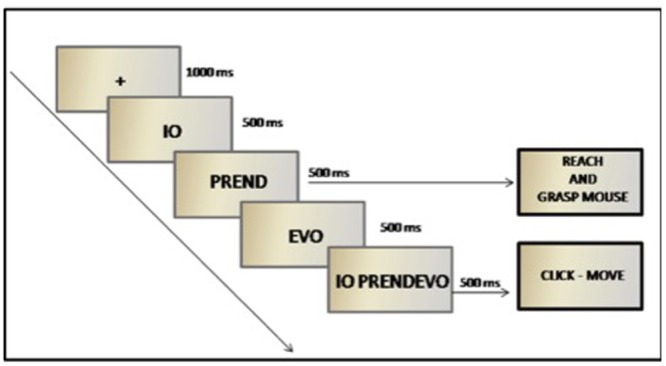
Experimental procedure.